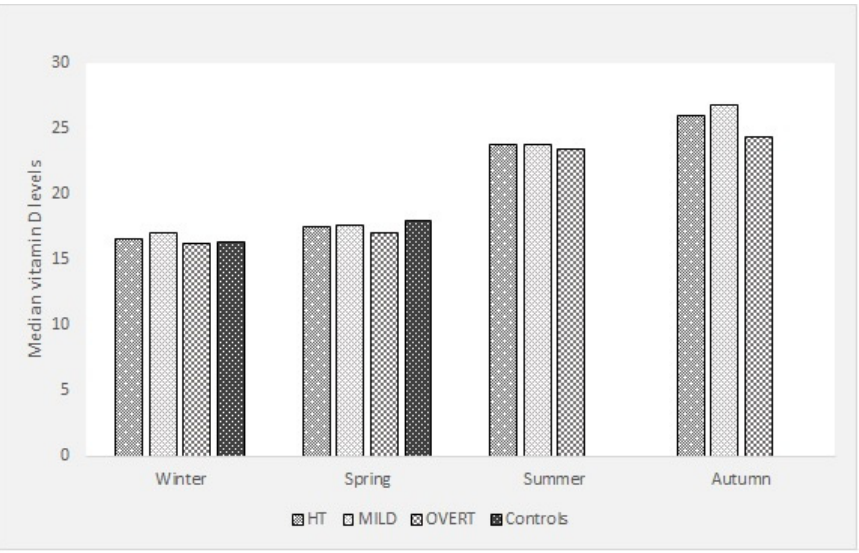
Figure 1. Seasonal distribution of vitamin D levels between groups of participants. Table 3. Comparison of proportions of individuals with vitamin D deficiency